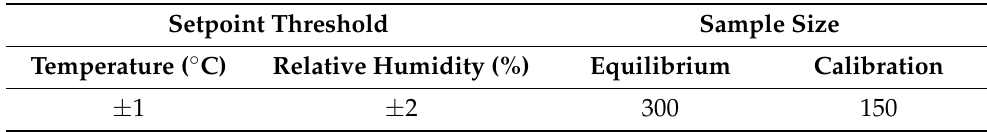
Table 3. Input parameters for the setpoint threshold and sample